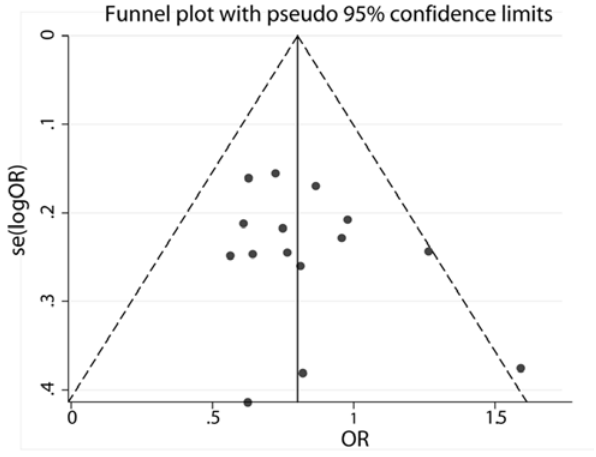
Figure 4: Begg’s funnel plot for association between ABCA1 R219K and ischemic stroke.